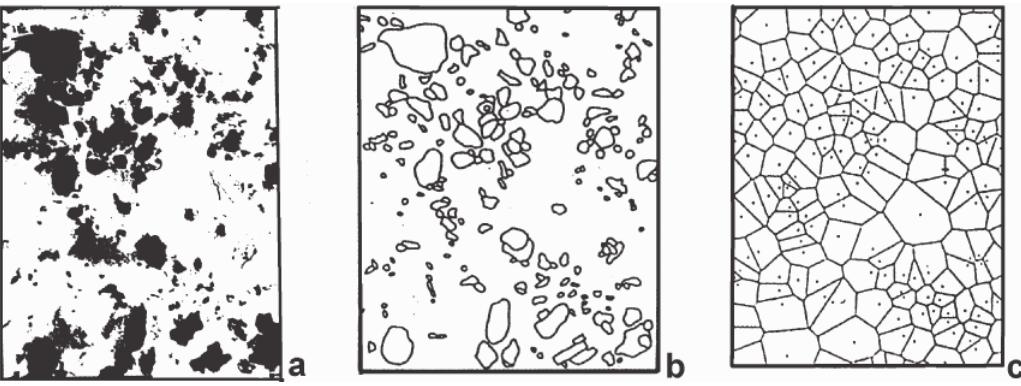
Fig. 8: Intermediate stages of evaluation for this foil (a), outlines of particles (b), and reference points (c)